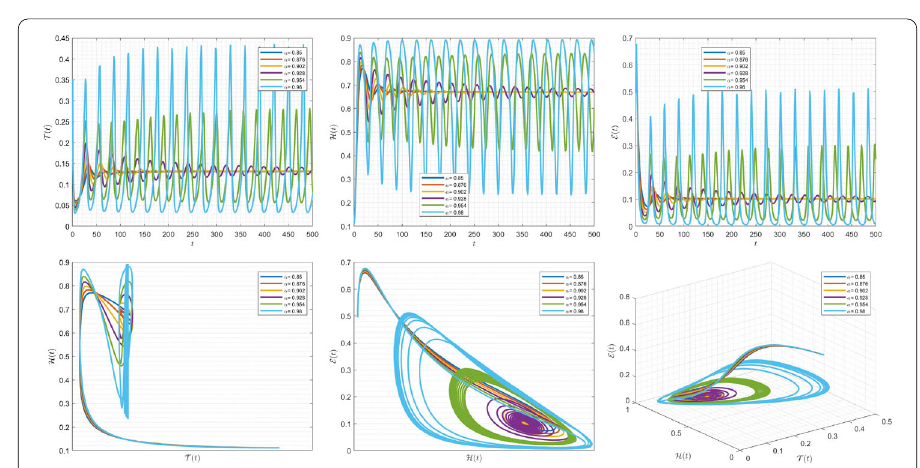
Figure 8 Simulations for solving (43) using (59) along with ( T (0), H (0), E (0)) = (0.3,0.3,0.3) and β 12 = 0.745